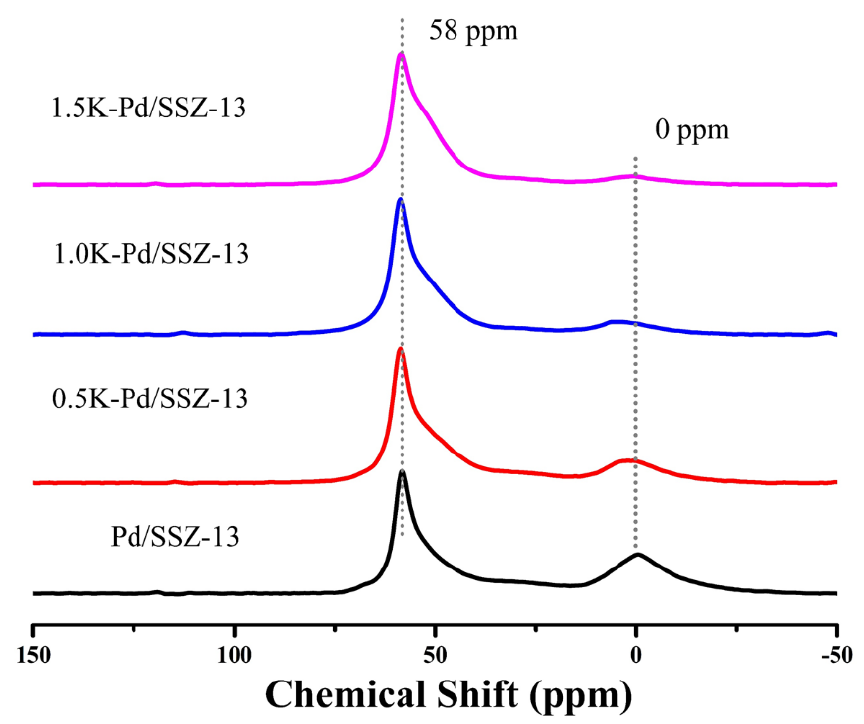
Figure 2. 27 Al NMR patterns of Pd/SSZ-13 and K-deactivated samples. Table 1. Physicochemical property of Pd/SSZ-13 and K-deactivated samples.